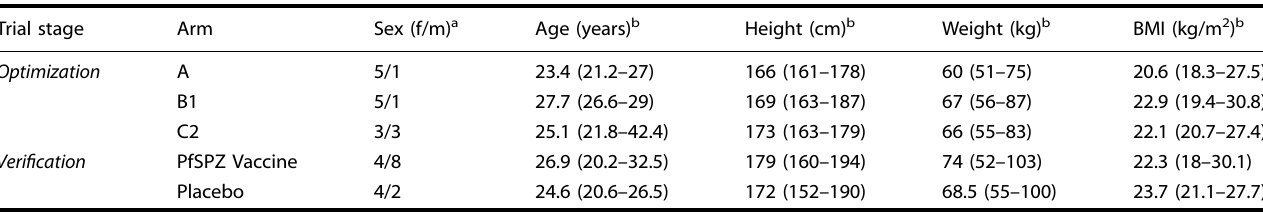
Table 1. Demographics of trial